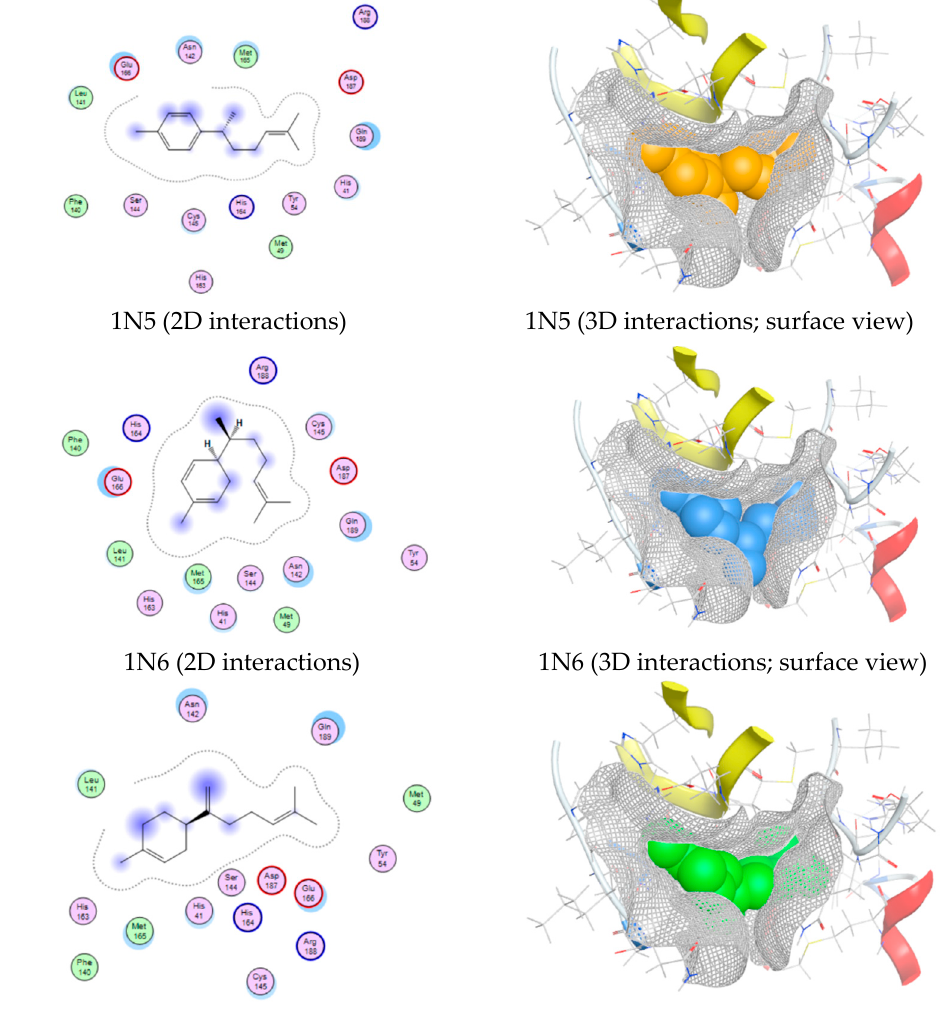
Figure 2. Docked images of the most active molecules. Ligand interactions within the active site pocket of the protein 6LU7, shown as 2D and 3D interactions; surface view inside the active site pocket. Viruses that infect humans are known to encode one or more proteases that are cru- cial in the viral life cycle. Proteases cleave the viral polyprotein, helping continue the viral replication process, and are ideal drug targets [53]. The SARS-CoV-2 replicase enzyme encodes two polyproteins, pp1a and pp1ab, that produce all the functional polypeptide units responsible for the replication and transcription of the virus. The catalytic cleavage activity of 3CLPro at various subsites of the polypeptide results in the release of the poly- peptides. This cleavage process is known to be conserved in the 3CLPro of all the corona- viruses [54], which is believed to play a vital role in viral replication. Interestingly, due to the absence of any close homolog in humans, this protease has been regarded as a prom- ising therapeutic target for COVID-19 treatment [55].